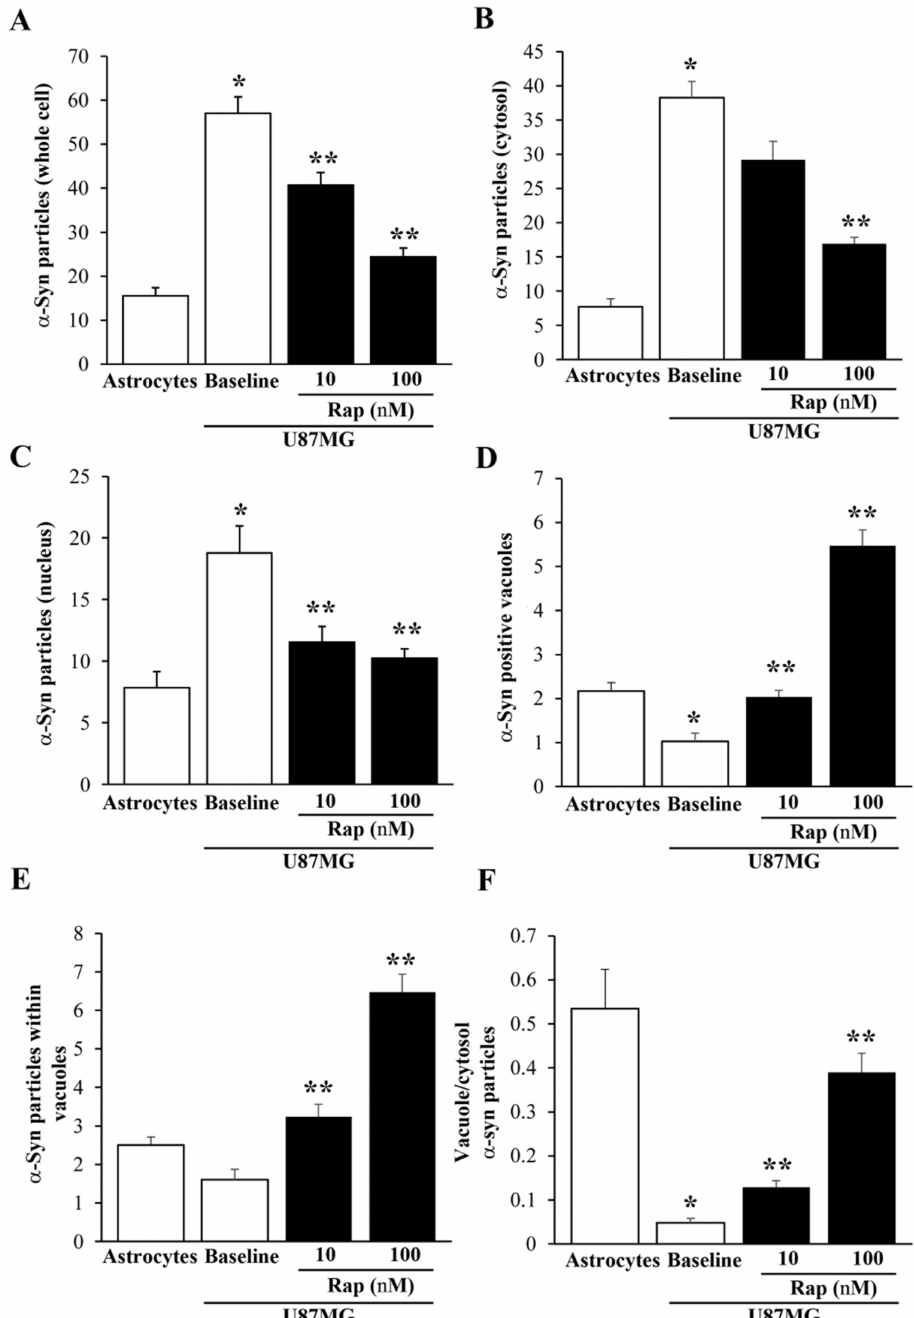
Figure 13. Counts of α -syn immuno-gold within the astrocytes and U87MG cells. Graphs report the number of α -syn immuno-gold particles within the whole cell ( A ), cytosol ( B ), and nucleus ( C ). The number of α -syn positive vacuoles is reported in ( D ), while the mean number of α -syn immuno-gold particles within each vacuole is reported in ( E ). The ratio of α -syn immuno-gold particles within vacuoles vs. the cytosol is reported in ( F ). These data were obtained from the astrocytes and U87MG cells, in baseline conditions and following rapamycin exposure (Rap 10 nM and Rap 100 nM). Data are given as the mean ± SEM from n = 30 cells per experimental group, obtained in N = 3 independent experiments. * p < 0.05 compared with astrocytes; ** p < 0.05 compared with